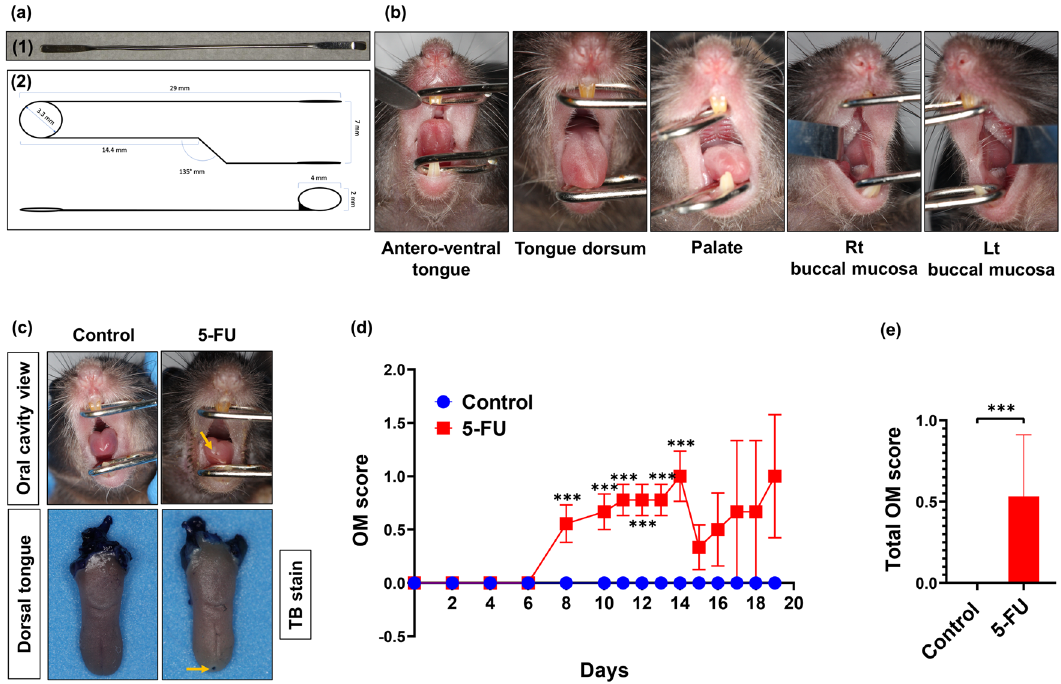
Figure 3. 5-FU treatment in mice induces chemotherapy-induced oral mucositis (CIOM). 5-FU (50 mg/kg/ day) was injected intravenously to group B at 2-days intervals, starting from day 1 to day 13. Group A (control) injected with saline. Oral mucositis (OM) was scored on a six-point scale as described in Methods. ( a ) Oral cavity examination tools; 1: Stainless steel laboratory micro spatula; 2: Schematic diagram of Celentano Murine Mouth Opener (CMMO). ( b ) Oral cavity examination views. Animals were sacrificed at different time points, and tongues collected. Tongues were stained with 1% toluidine blue (TB) in 10% acetic acid. ( c ) Representative photographs show oral mucosa with diffuse erythema on the antero-dorsal surface of the tongue in treated mice, with representative tongues after TB staining showing the epithelium ulceration (blue) at the dorsal surface of the tongue. Yellow arrows show areas of erythema, erosion, and ulceration. ( d ) Comparative OM scores, error bars = mean ± SEM. *** P < 0.001 versus control group. Multiple t tests were used to determine the statistical significance between the two groups. ( e ) Mean value of the total score of OM between day-0 and day-19 for each group. Unpaired student t test was used to determine the statistical significance between groups. Data are the mean ± SEM (in = 9 for group A and B). *** p <